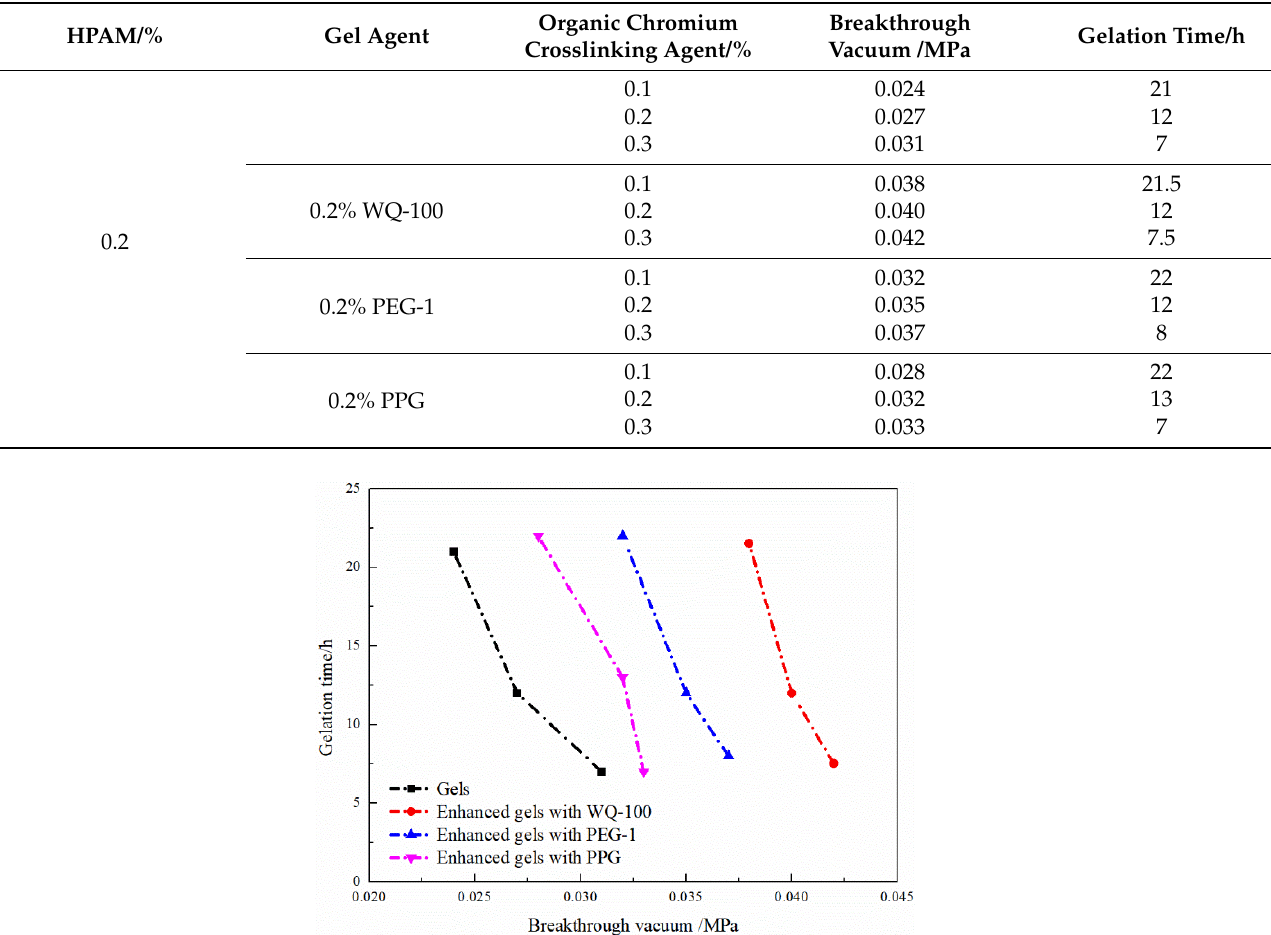
Table 4. Strength and gelation time of gel compounds system.